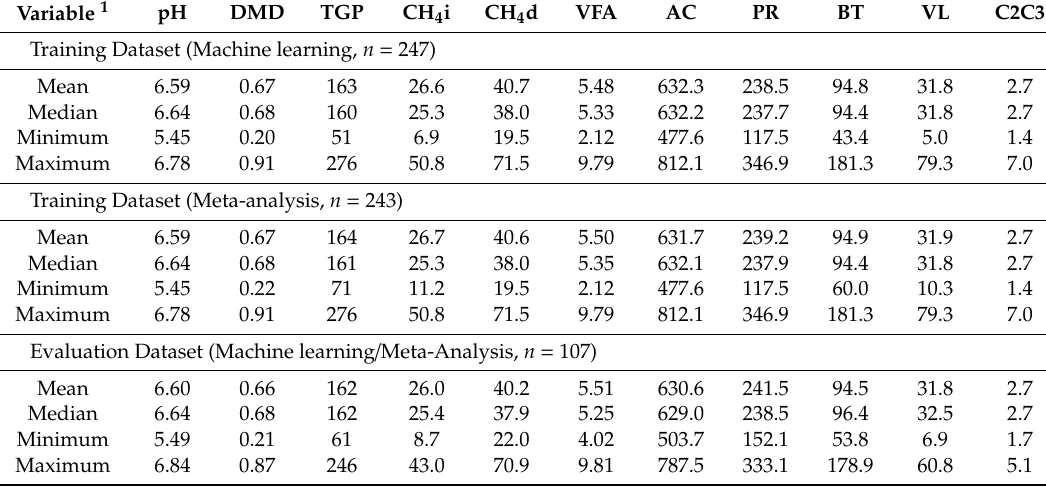
Table 1. Summary of the training ( n = 247, 243) and internal evaluation ( n = 107)